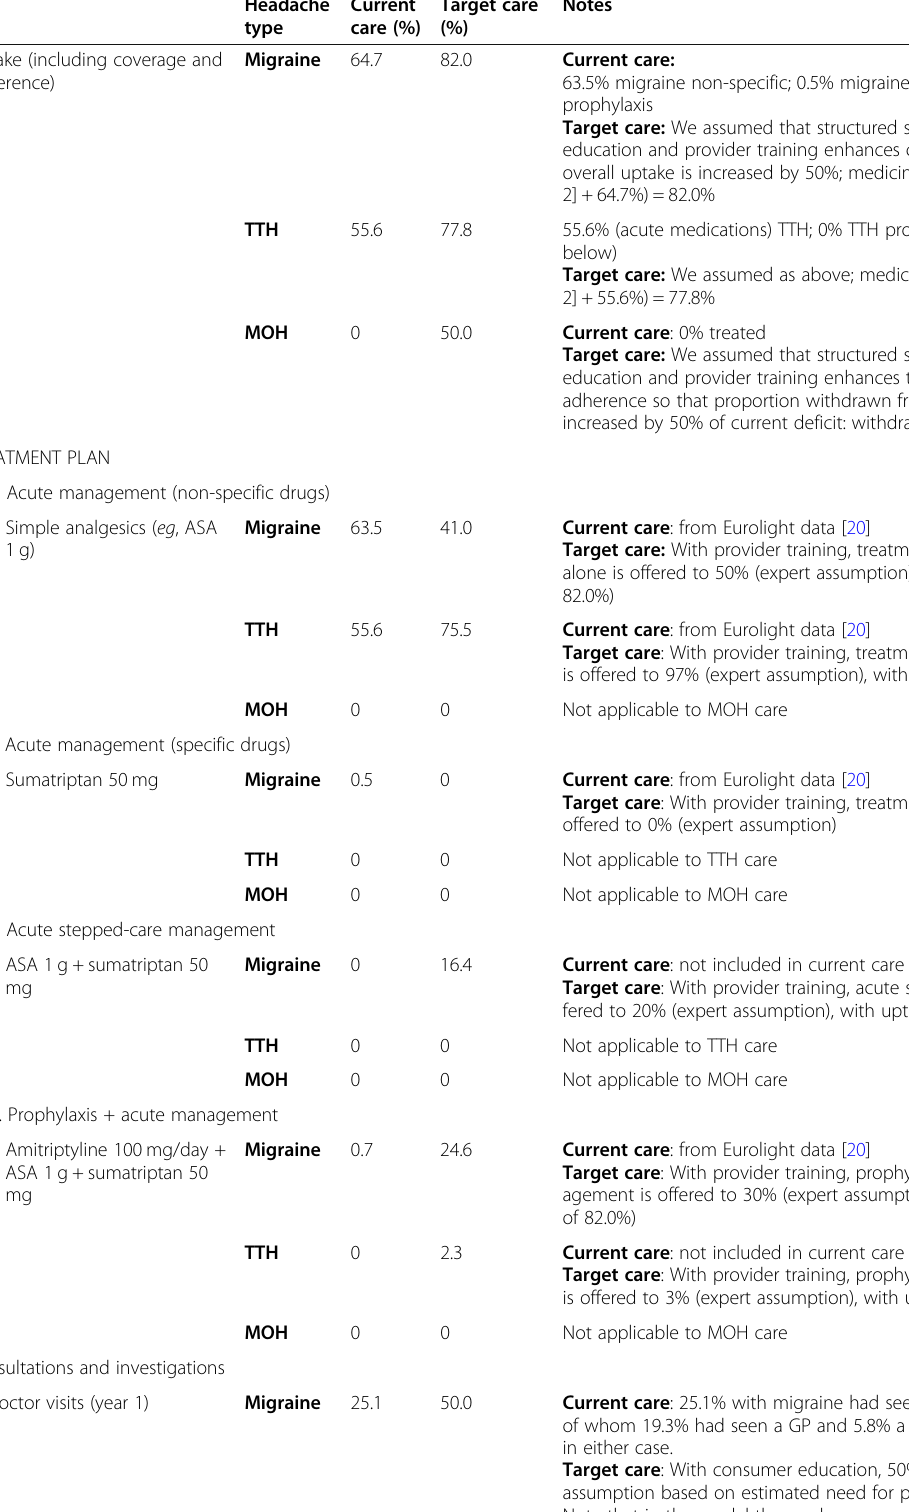
Table 2 Treatment uptake, use of resources and lost productivity according to treatment management plan